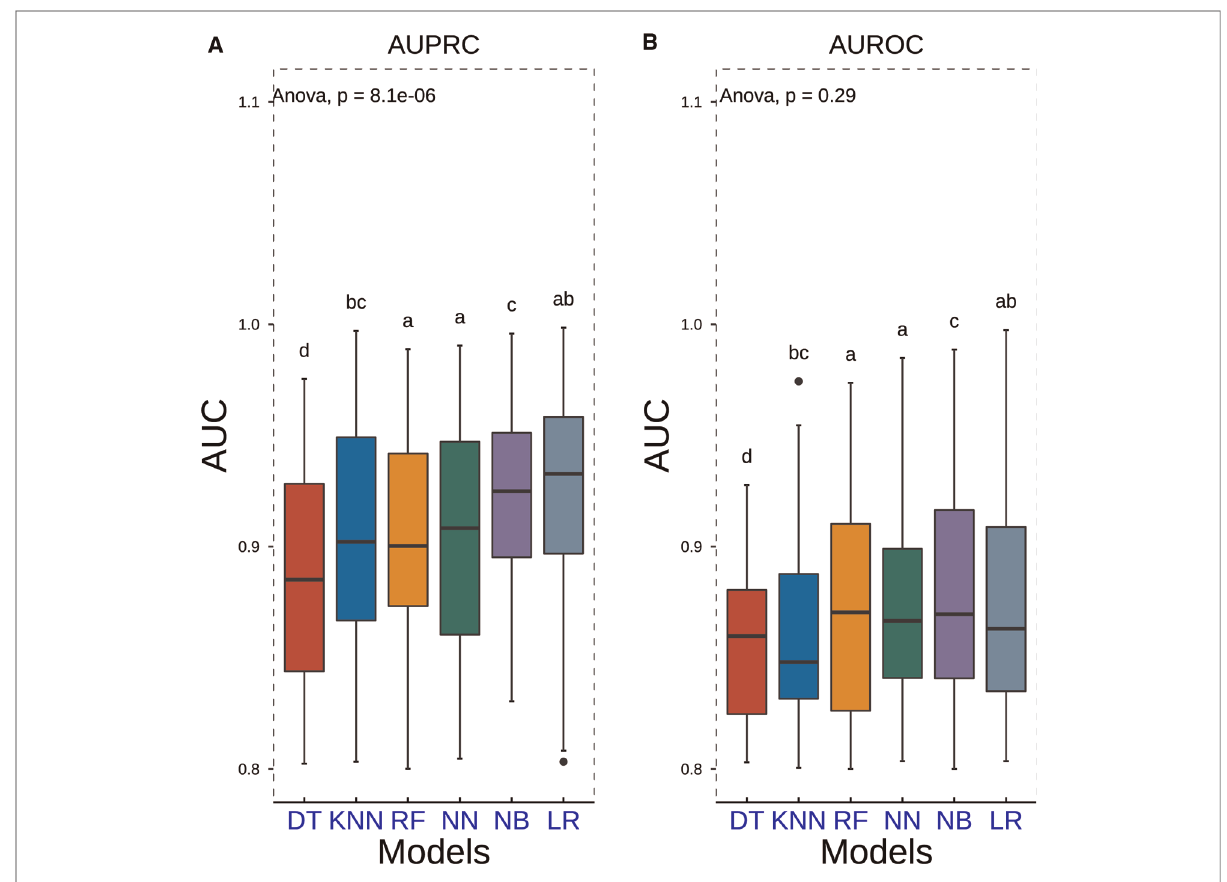
FIGURE 3 Boxplots of AUPRC and AUROC measurements of model performance using the nested resampling strategy for six different machine learning algorithms. P- values were calculated through one-way analysis of variance with Tukey ’ s posthoc test. AUPRC, area under the curve of the receiver operating characteristic curve; AUPRC, area under the curve of the precision – recall